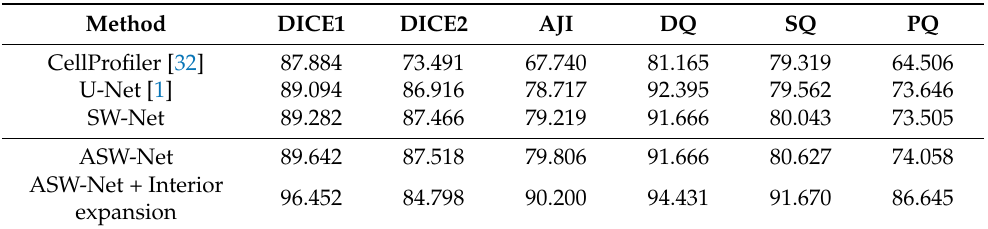
Table 1. The performance comparison between ASW-Net and other existing methods on BBBC039 nuclei